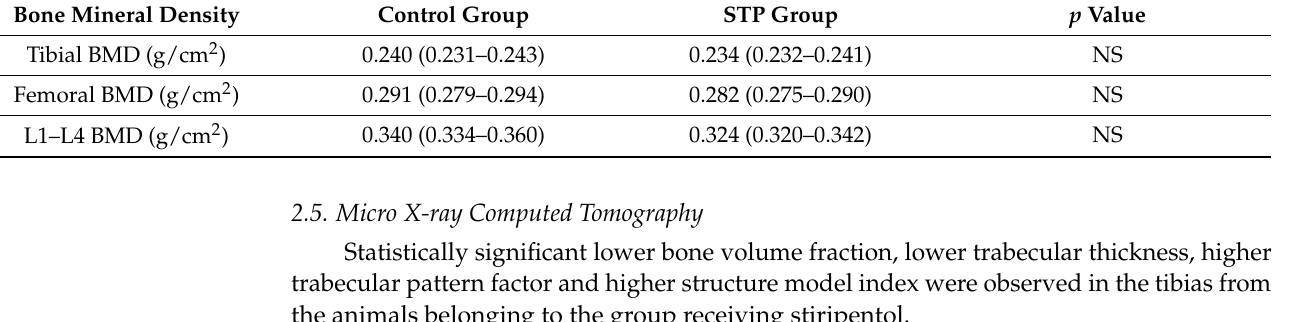
Table 3. The effect of 24 weeks administration of stiripentol on bone mineral density (BMD) (group STP—group received stiripentol for 24 weeks). Results presented as: median (lower quartile—upper quartile); NS—not significant. Bone Mineral